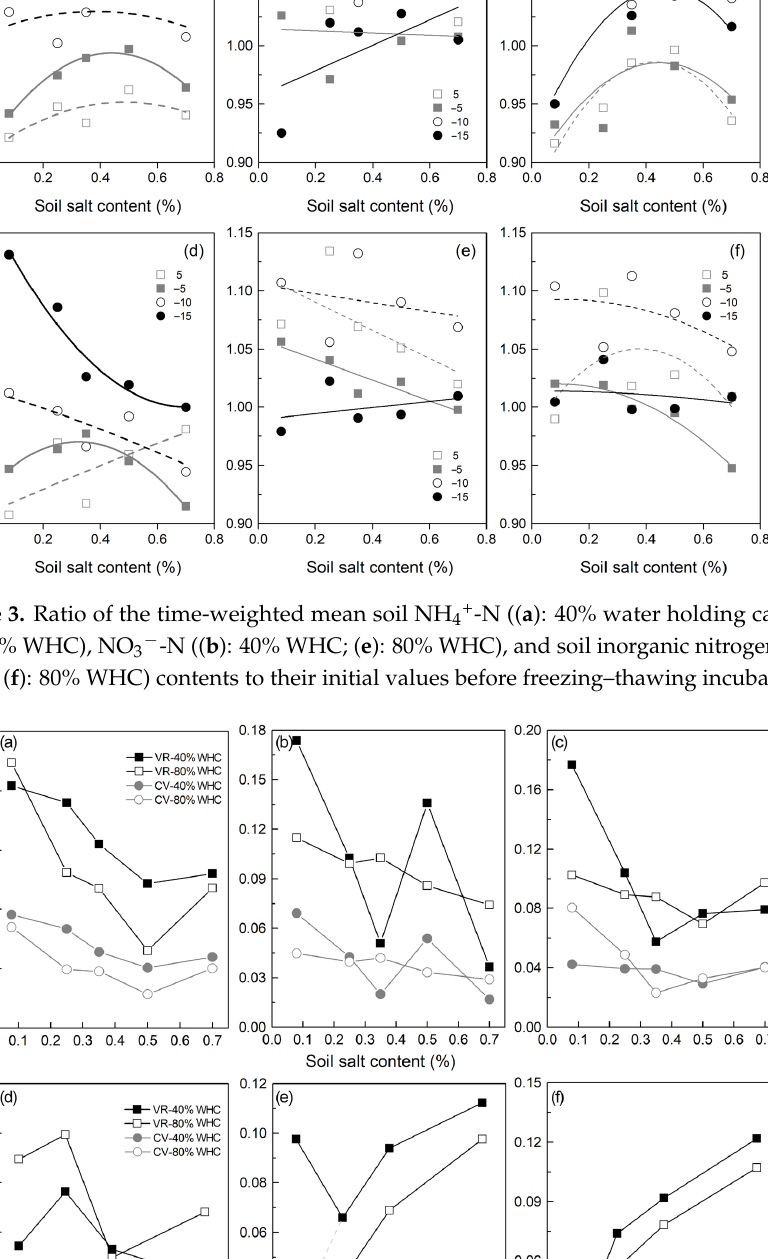
Figure 4. Variation ranges and coefficients of variation of relative soil N (NH 4+ -N, NO 3 − -N and SIN) induced by different freezing temperatures in different soil salt content (SSC) and soil water content (SWC) treatments ( a–c ), and induced by SSC in different freezing–thawing (FT) and SWC treatments ( d–f ). The differences in relative N content compared to its initial values between SWC (80% WHC) treatments and SWC (40% WHC) treatments are shown in Figure 4. The rel- ative NH 4+ -N contents in SWC (80% WHC) treatments were lower than in SWC (40% WHC) treatments when they were exposed to a combination of low temperature and high salt (SSC × freezing temperature < − 2.5% °C) (Figure 5). The relative NO 3 − -N and SIN con- tents were higher in SWC (80% WHC) treatments when SSC was lower than 0.35%. Figure 5. Differences in relative NH 4+ -N ( a ), NO 3 − -N ( b ), and soil inorganic nitrogen (SIN) ( c ) con- tents compared to their initial values between soil water content treatments (80% water holding capacity (WHC) vs. 40% WHC).